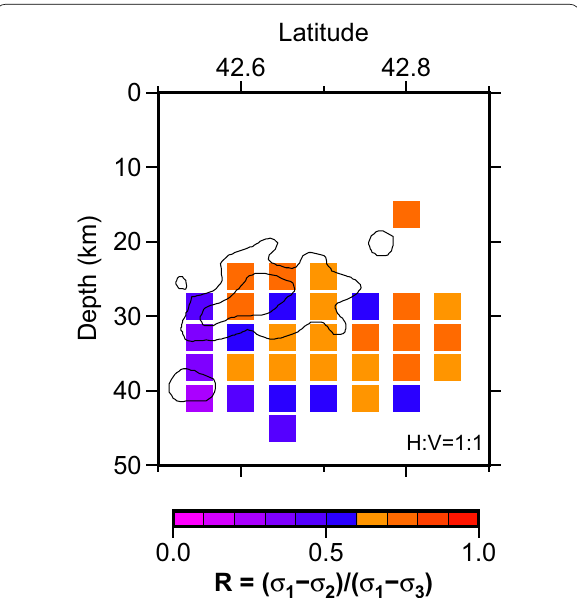
Fig. 9 Distribution of the stress ratio R in vertical cross section. The coseismic slip was indicated by contours with 0.6 and 1.2 m (Asano